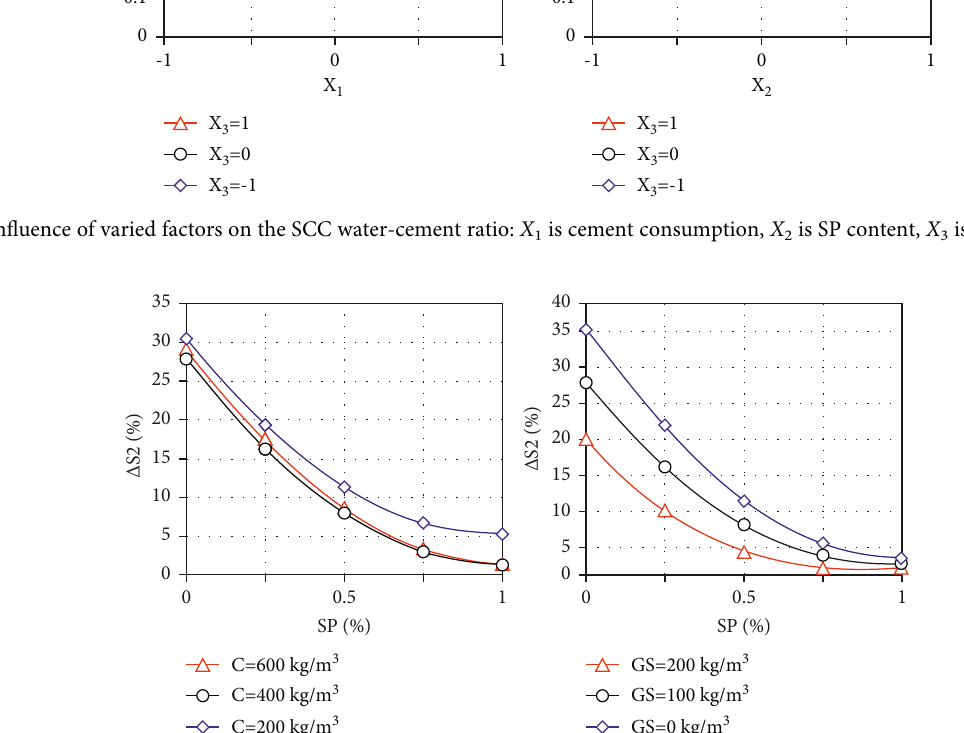
Figure 3: Dependence of SCC mix workability retention at 2hours ( Δ S2,%) on superplasticizer